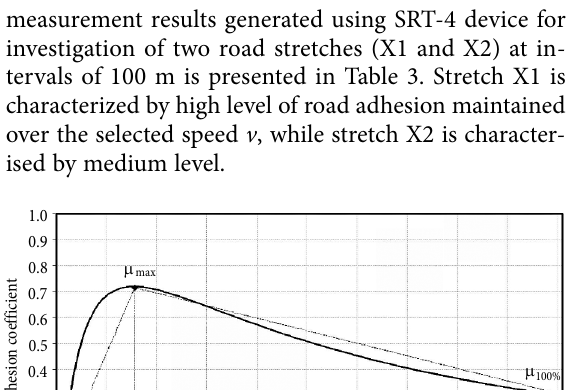
Longitudinal slip ( ) µ = f s Fig. 11. Grip ratio variation: zone I – stable braking conditions; zone II – unstable braking conditions